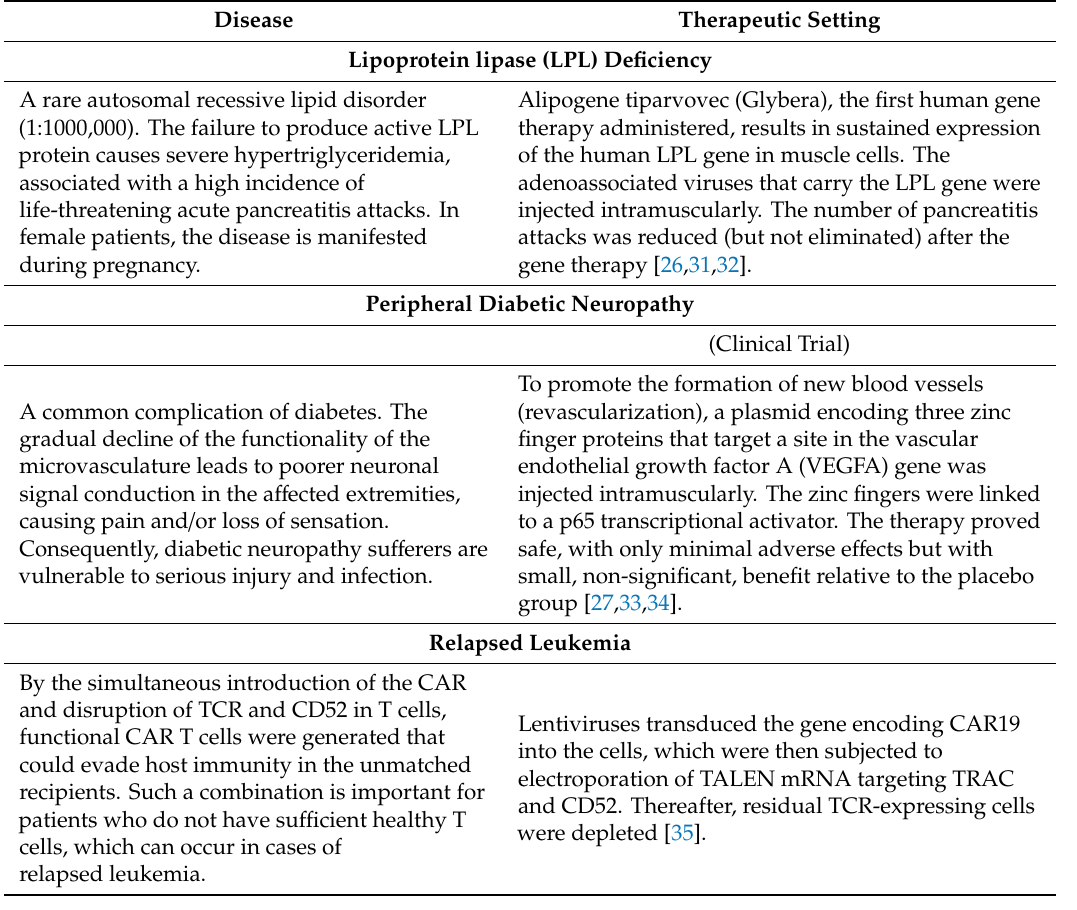
Table 1. Therapies or clinical trials employing control of gene expression.